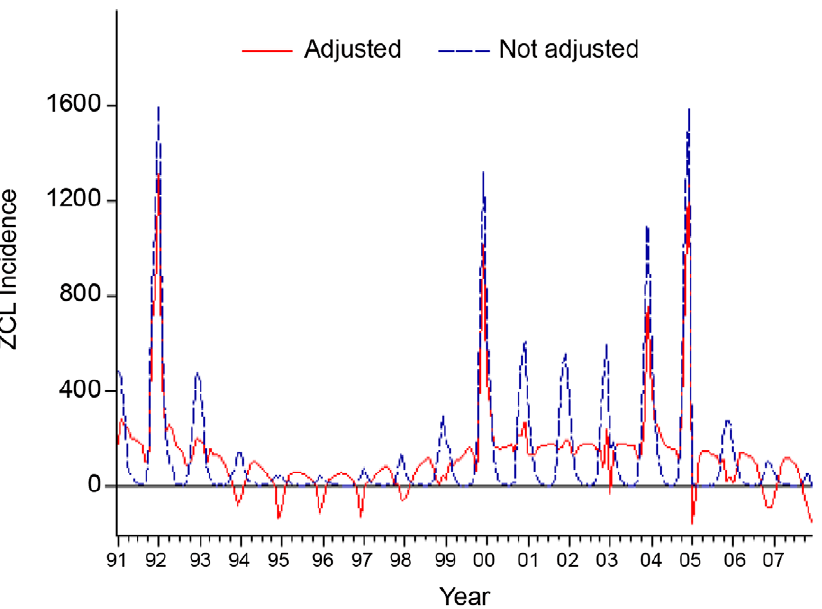
Figure 4. Monthly ZCL incidence adjusted vs not adjusted for monthly seasonality (1991–2007).